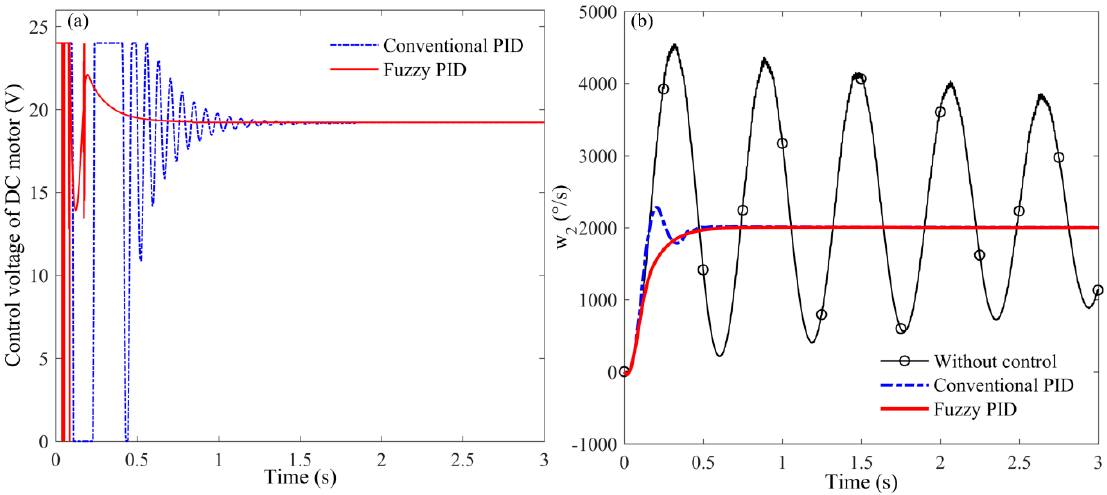
Figure 8. Control effects of the designed fuzzy PID controller and the conventional PID controller on the torsional vibration of the flexible-joint robot system: ( a ) control voltages of the DC motor; ( b ) speed of joint II.